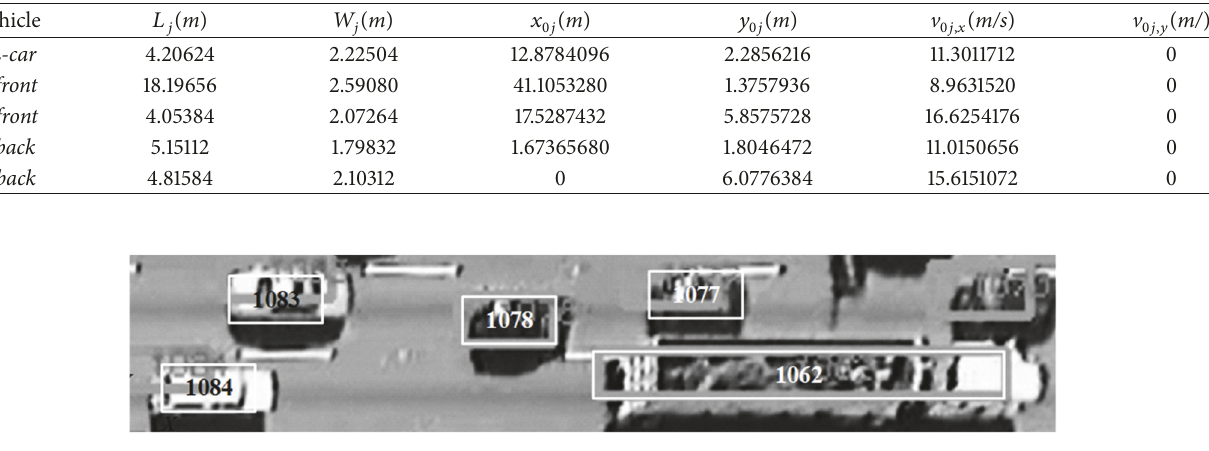
Table 4: Vehicle basic data.